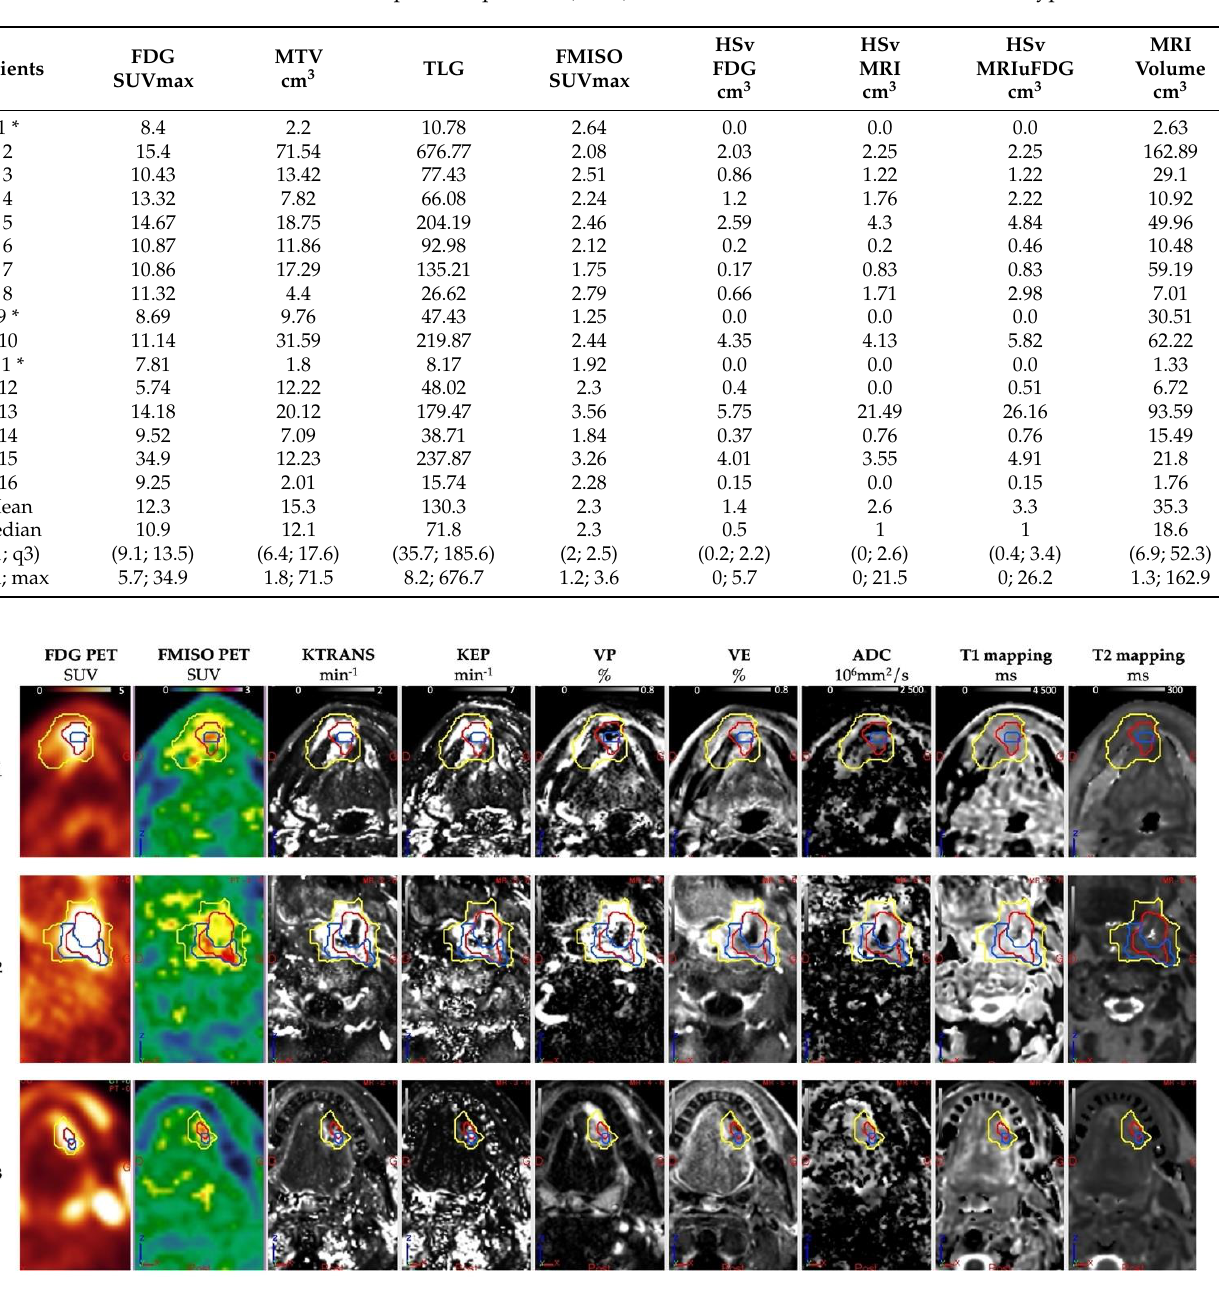
Table 3. Quantitative parameters of SUV and MRI volumes extracted from FDG PET, FMISO PET and MRI. * represents patients ( n = 3) whose tumor lesion does not contain a hypoxia sub-volume.